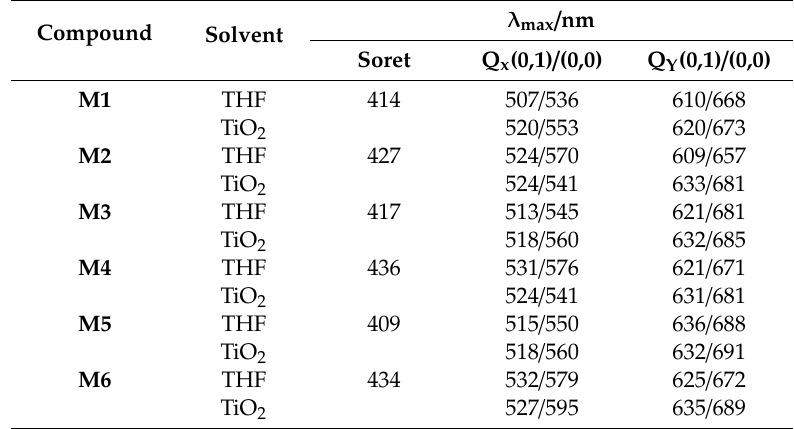
Table 1. Spectral characteristics of chlorin derivatives M1 – M6 in THF solution and grafted on the TiO 2